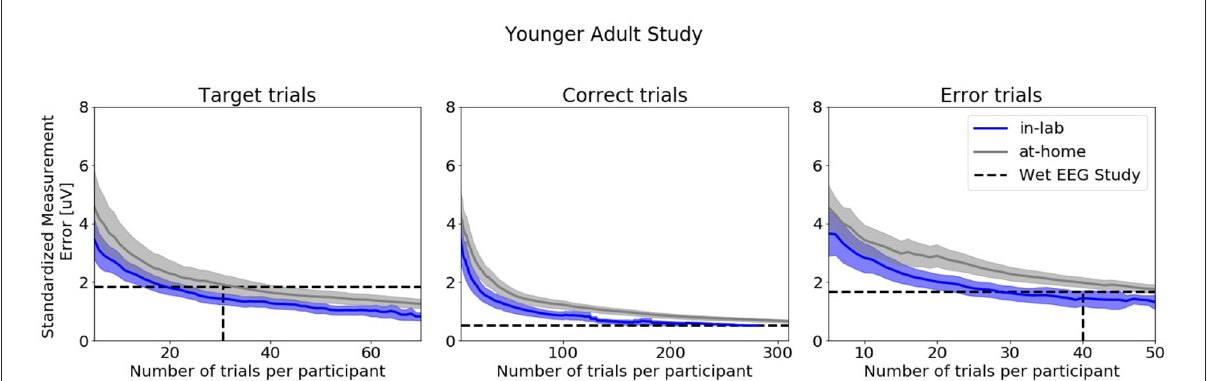
FIGURE8 Standardized Measurement Errors per number of trials of data collected in the laboratory under researcher supervision extracted from the Younger Adult Study ( N 30). The blue line corresponds to data collected in the laboratory. The gray line corresponds to data collected in the = home. The black dotted lines correspond to the mean numbers of trials extracted from the wet EEG study. From left to right: Target Trials extracted from the Oddball task at electrode Pz, Correct Trials extracted from the Flanker task at electrode FCz, Error Trials extracted from the Flanker task at electrode FCz. The shaded areas correspond to the 95% confidence